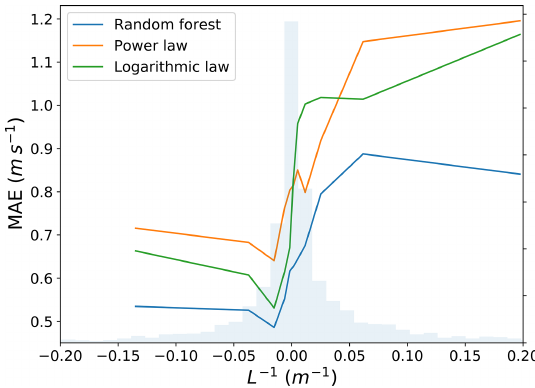
Figure 5. Testing MAE in predicting wind speed at 143ma.g.l. as a function of atmospheric stability, measured in terms of the inverse of the Obukhov length, for the random forest, power law, and loga- rithmic law, at the C1 site. The distribution of L − 1 is shown in light